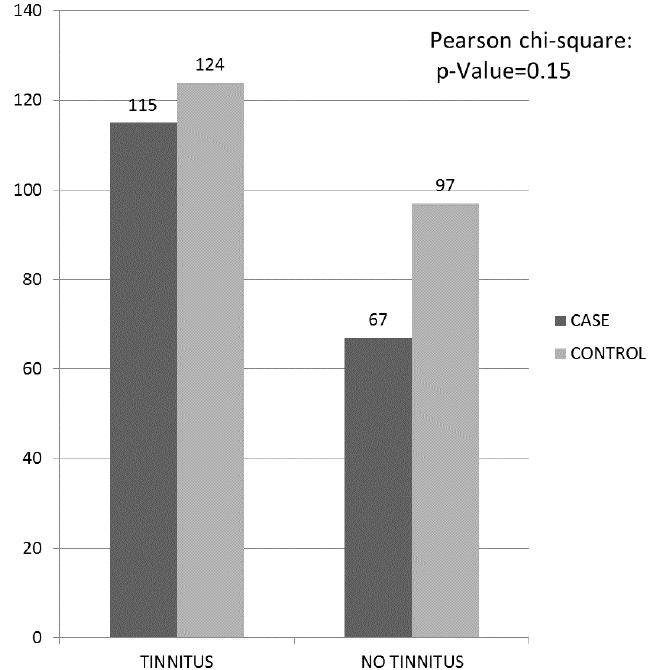
Figure 2. Incidence of tinnitus among cases and controls (182 cases and 221 controls).